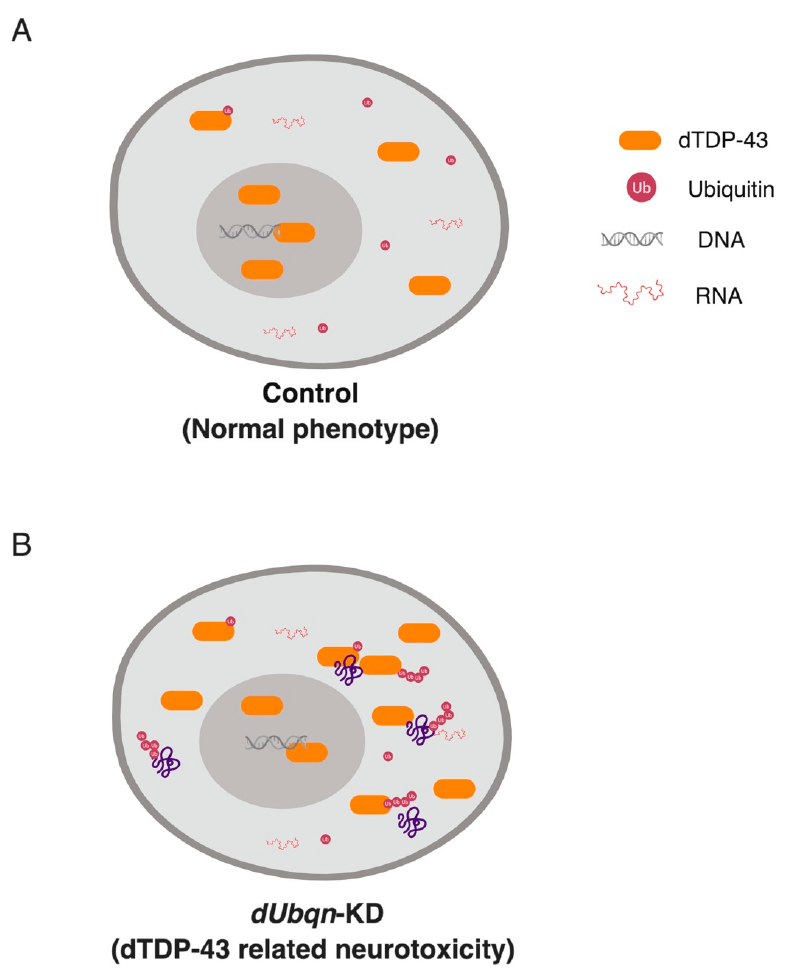
Figure 4. UBQLN2 loss-of-function causes a TDP-43-like pathology in the fly [33]. ( A ) Under physiological conditions, TDP-43 shuttles between nuclear and cytoplasmic compartments. ( B ) The depletion of Drosophila UBQLN2 functions by RNAi triggers the abnormal accumulation of toxic cytoplasmic